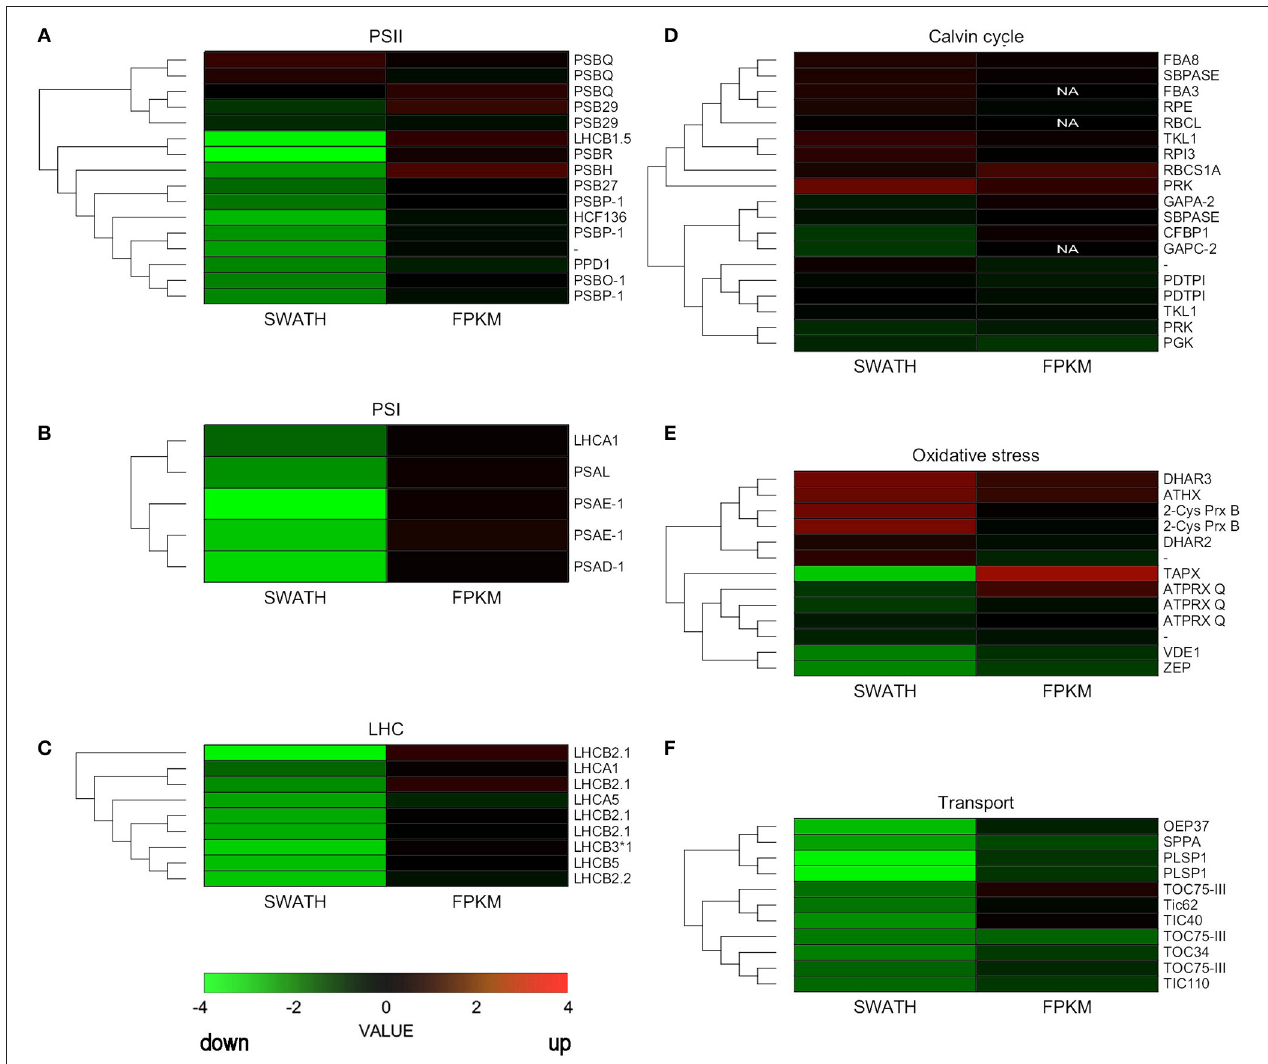
FIGURE 4 | Hierarchical clustering analysis of transcriptomic and proteomic data. Heatmap of the gene and protein expression patterns of key genes/proteins in the seven functional groups indicated (A–F) . The left portion of each heatmap represents proteomic data (SWATH), and the right represents transcriptomic data (FPKM). The color code is as follows: red indicates up-regulated proteins or transcripts in protoplasts; green indicates down-regulated proteins or transcripts in protoplasts; black indicates unchanged proteins or transcripts in protoplasts. Each row represents the log1,4 (Protoplasts/Protonema. PP/PN) of a protein or the log2 (PP/PN) of a transcript. The color scale of the heatmap ranges from saturated green (value, − 4.0) to saturated red (value, 4.0) in the natural logarithmic scale. PSI, Photosystem I; PSII, photosystem II; LHC, light-harvesting